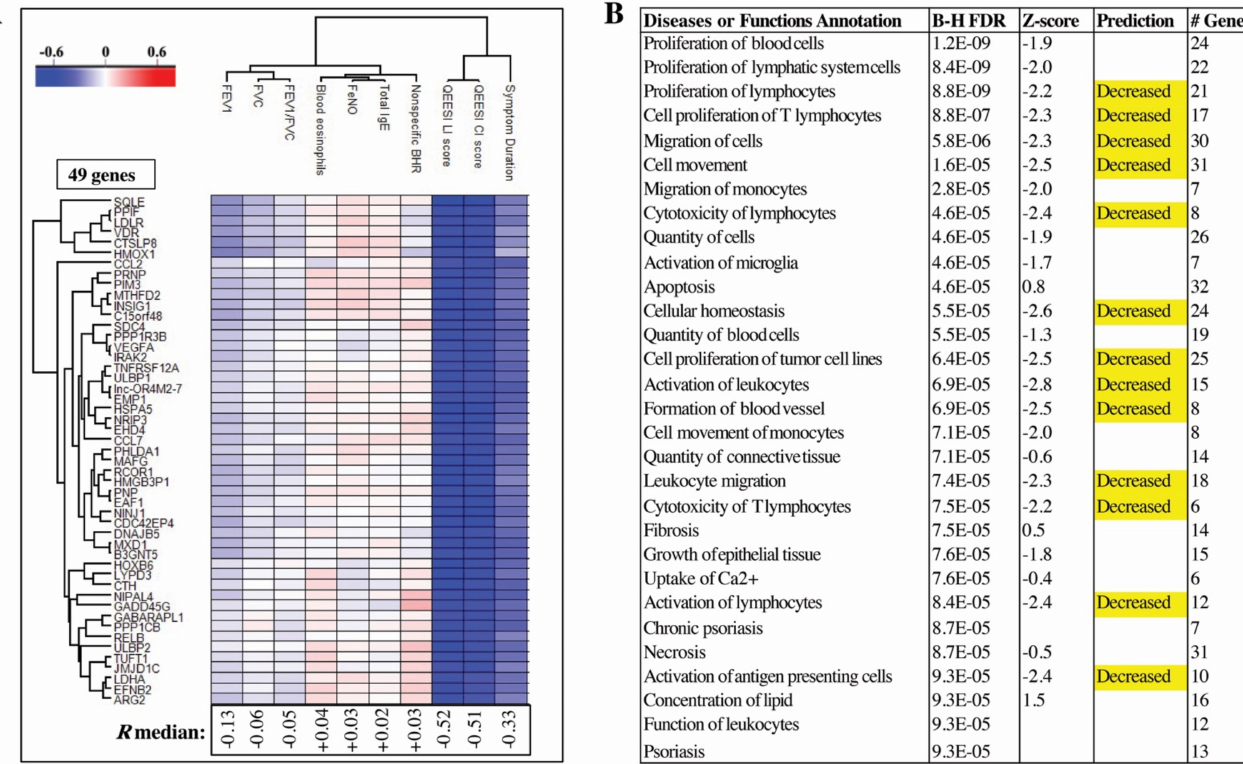
Figure 7. Regression analyses of differentially expressed genes (DEGs) and selected clinical parameters relevant to diagnosis of asthma and/or idiopathic environmental intolerance identified 49 genes with a Pearson’s correlation coefficient of R >|0.5| to at least 1 clinical parameter. A hierarchical cluster of correlated genes (cutoff R > |0.5|) and clinical parameters is shown in ( A ). The correlation coefficients of these 49 genes clusters the clinical parameters into 2 main clusters. The strongest correlations were identified in both the QEESI chemical intolerance (CI) and life impact (LI) scores, wherein expression of all 49 genes was negatively correlated with QEESI scores across the entire study cohort. Pathway analysis of these 49 genes predicted highly significant enrichment of genes involved in suppression of immune cell activation, proliferation, and/or migration ( B ). BHR is non-specific bronchial hyperresponsiveness, CI is chemical intolerance, FeNO is fractional exhaled nitric oxide, FEV1 is forced expiratory volume in one second, FVC is forced vital capacity, IgE is immunoglobin E, LI is life impact, and QEESI is Quick Environmental Exposure and Sensitivity